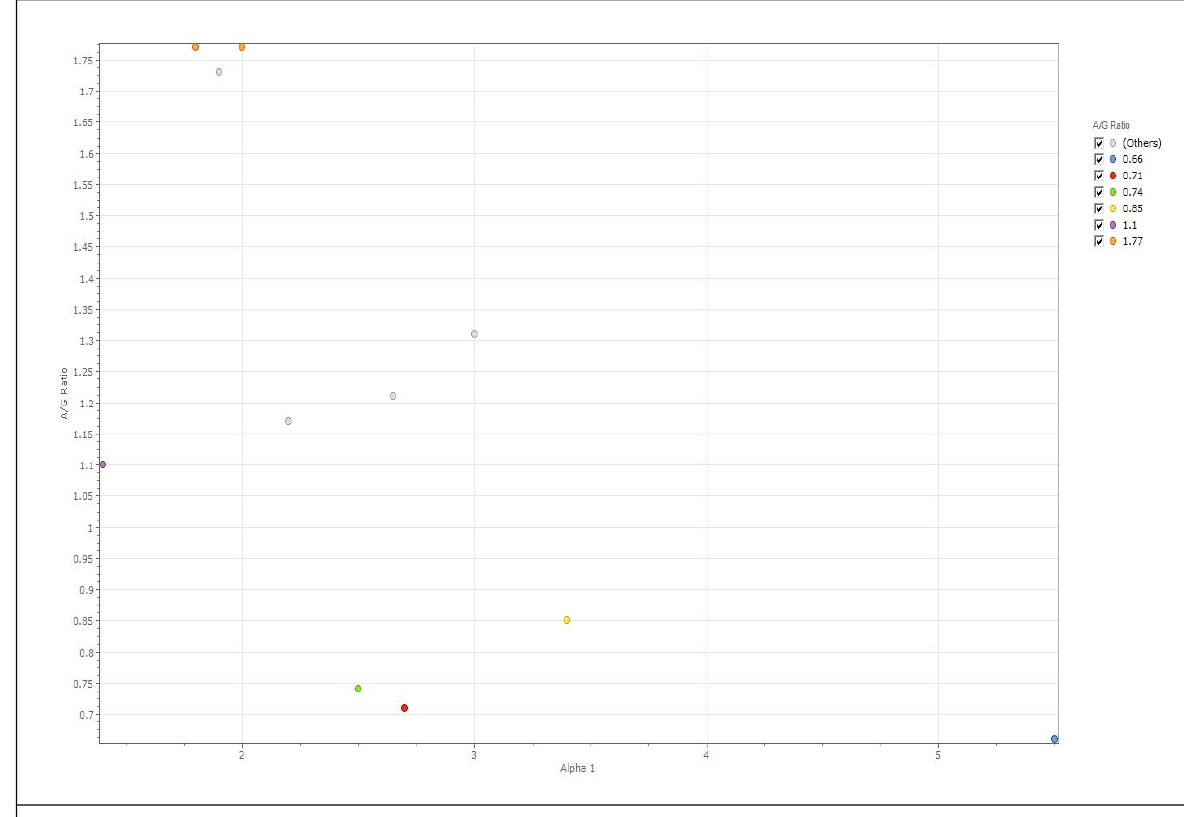
Figure 6: Scatter plot of A/G ratio with respect to alpha 1